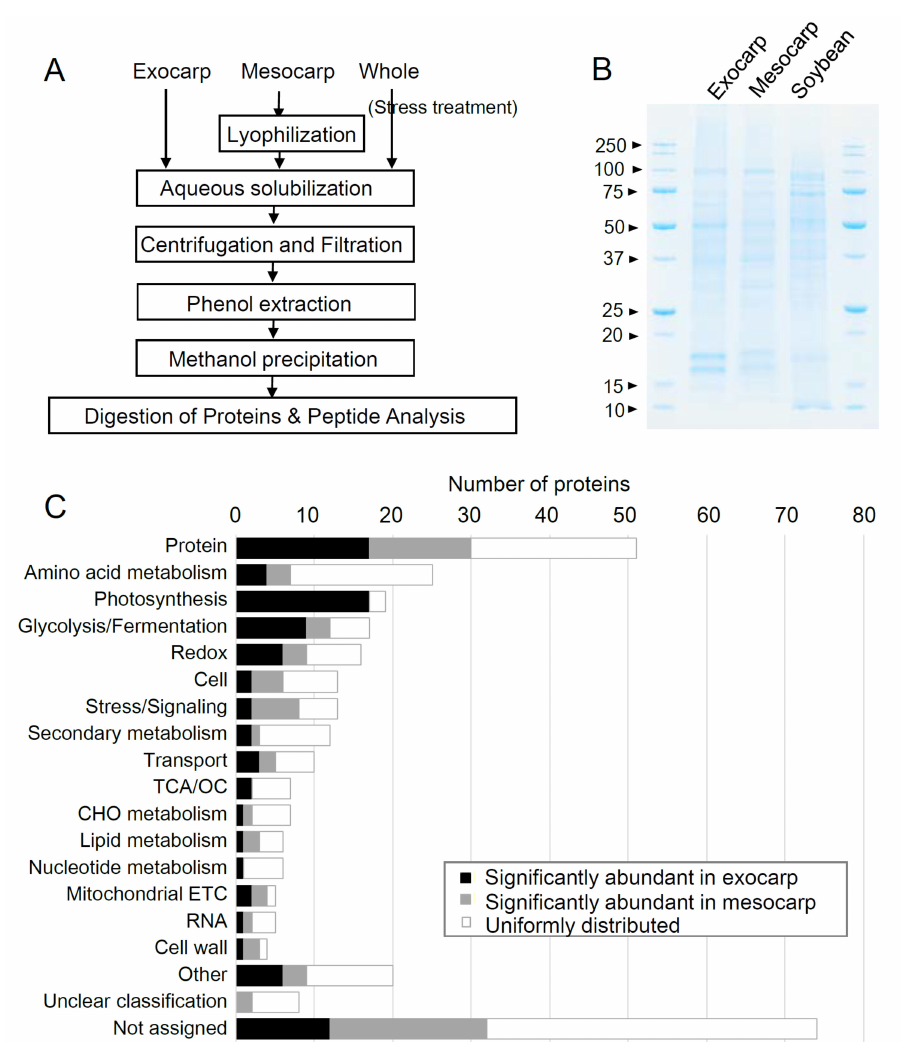
Figure 1. ( A ) Our optimized protein extraction method enables LC–MS/MS analysis of Opuntia proteins without electrophoretic separation. ( B ) Comparison of the optimized protein extraction method for O. ficus-indica and the TCA/acetone method applied to soybean. Proteins (5 µ g for each sample) were visualized with Coomassie Brilliant Blue stain. ( C ) The number of detected proteins belonging to each functional category is shown. Differentially abundant proteins between tissues are grouped. Abbreviations: TCA/OC, tricarboxylic acid/organic acid transformations; CHO metabolism, carbohydrate metabolism; mitochondrial ETC, mitochondrial electron transport chain. Other includes development, C1 metabolism, hormone metabolism, biodegradation of xenobi- otics, DNA, N-metabolism, oxidative pentose phosphate pathway, and miscellaneous